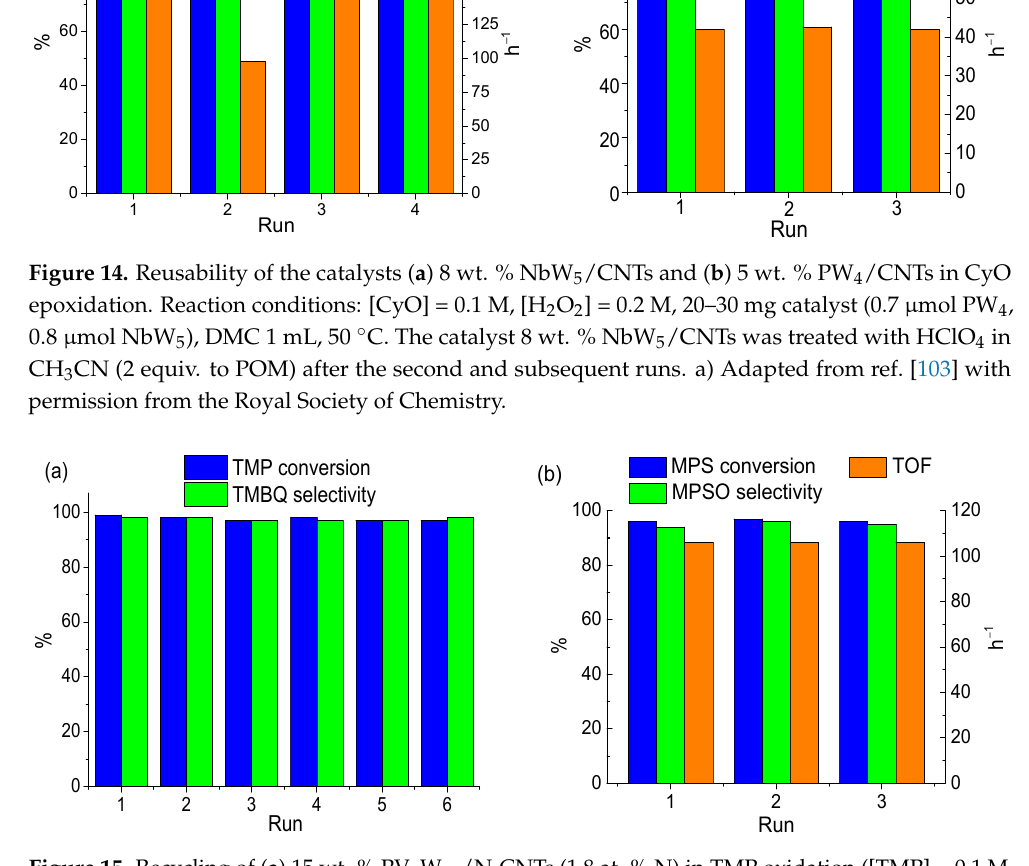
Figure 15. Recycling of ( a ) 15 wt. % PV 2 W 10 /N-CNTs (1.8 at. % N) in TMP oxidation ([TMP] = 0.1 M, [H 2 O 2 ] = 0.45 M, catalyst 40 mg (1.6 μ mol PV 2 W 10 ), CH 3 CN 1 mL, 15 min, 60 °C) and ( b ) 15 wt. % PW 4 /CNTs in MPS oxidation ([MPS] = 0.1 М , [H 2 O 2 ] = 0.1 М , catalyst 15 mg (1 μ mol PW 4 ), CH 3 CN 1 mL, 27 °C).